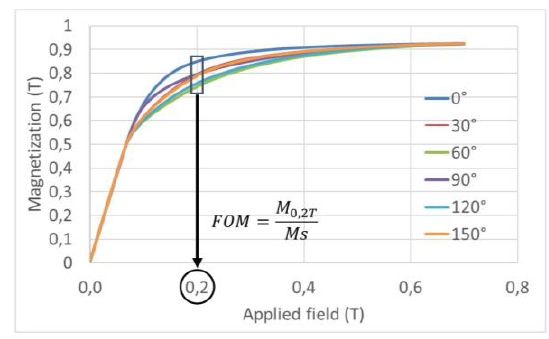
Figure 2. Example of in-plane hysteresis loops (upper branch only) at different azimuthal applied field angles for monocrystalline Terfenol-D